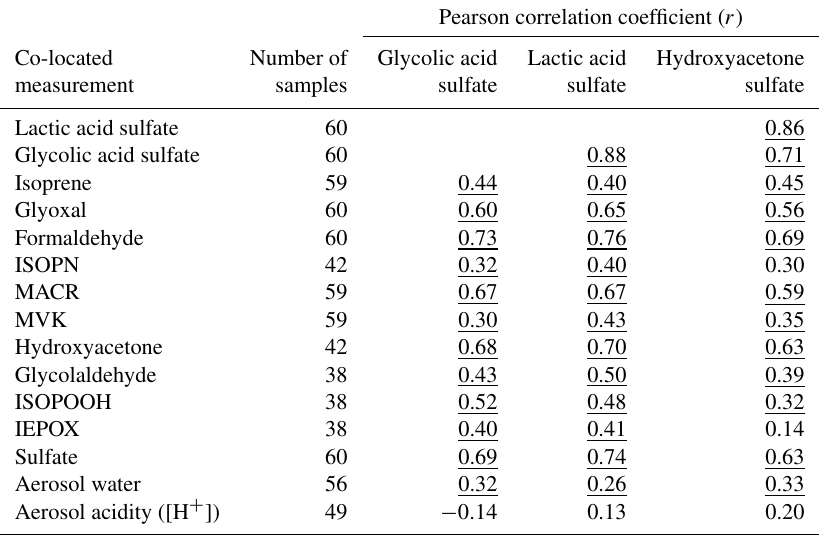
Table 2. Correlations of hydroxyacetone sulfate, lactic acid sulfate, and glycolic acid sulfate with each other and co-located measure- ments: isoprene, glyoxal that is formed from both isoprene high and low NO x oxidation pathways, formaldehyde, isoprene hydroxyl nitrates (ISOPN), methacrolein (MACR), methylvinyl ketone (MVK) that are isoprene high NO x oxidation products, hydroxyacetone and glyco- laldehyde that are further oxidation products of MACR and MVK, respectively, and isoprene hydroxyl hydroperoxides (ISOPOOH) and isoprene dihydroxy epoxides (IEPOX) that are isoprene low NO x oxidation products, sulfate, aerosol water, and aerosol acidity. Underlined correlation coefficients are statistically significant at 95% confidence